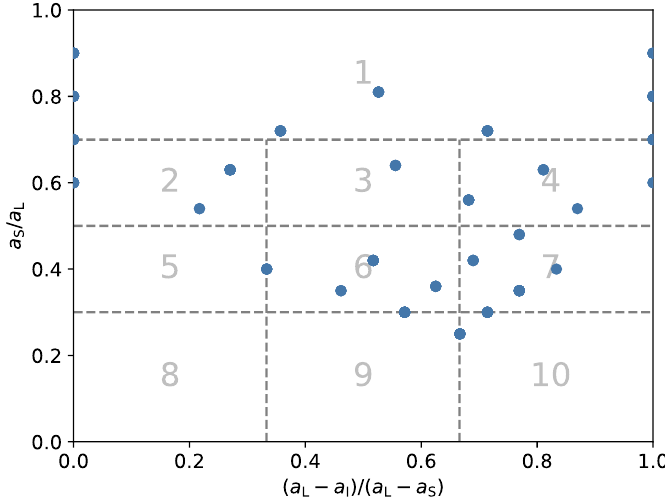
Figure 10. The particles considered in this study are plotted for a shape classification according to Sneed and Folk [6]. They are also classified regarding the compactness, leading to the ten shape classes 1: compact, 2: compactly platy, 3: compactly bladed, 4: compactly elongated, 5: platy, 6: bladed, 7: elongated, 8: very platy, 9: very bladed and 10: very